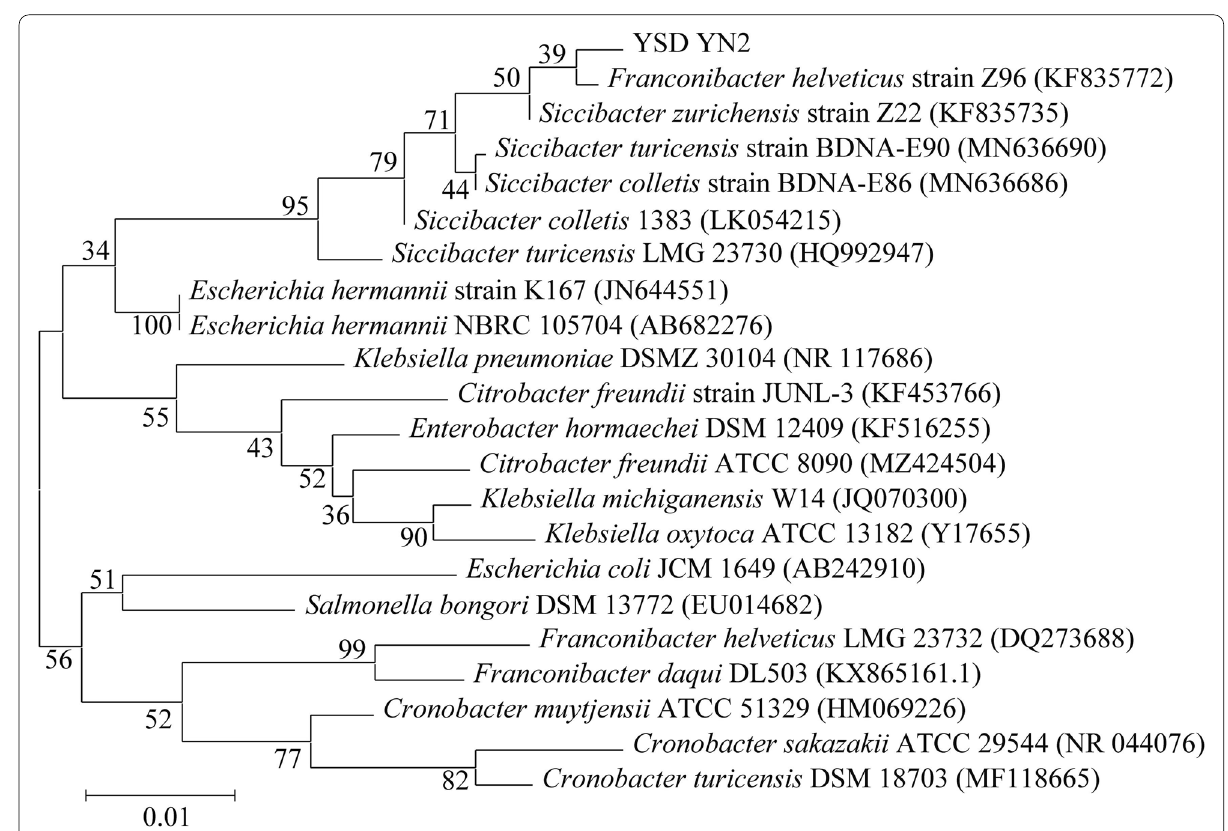
Fig. 1 Phylogenetic tree of the strain YSD YN2 based on 16S rDNA gene